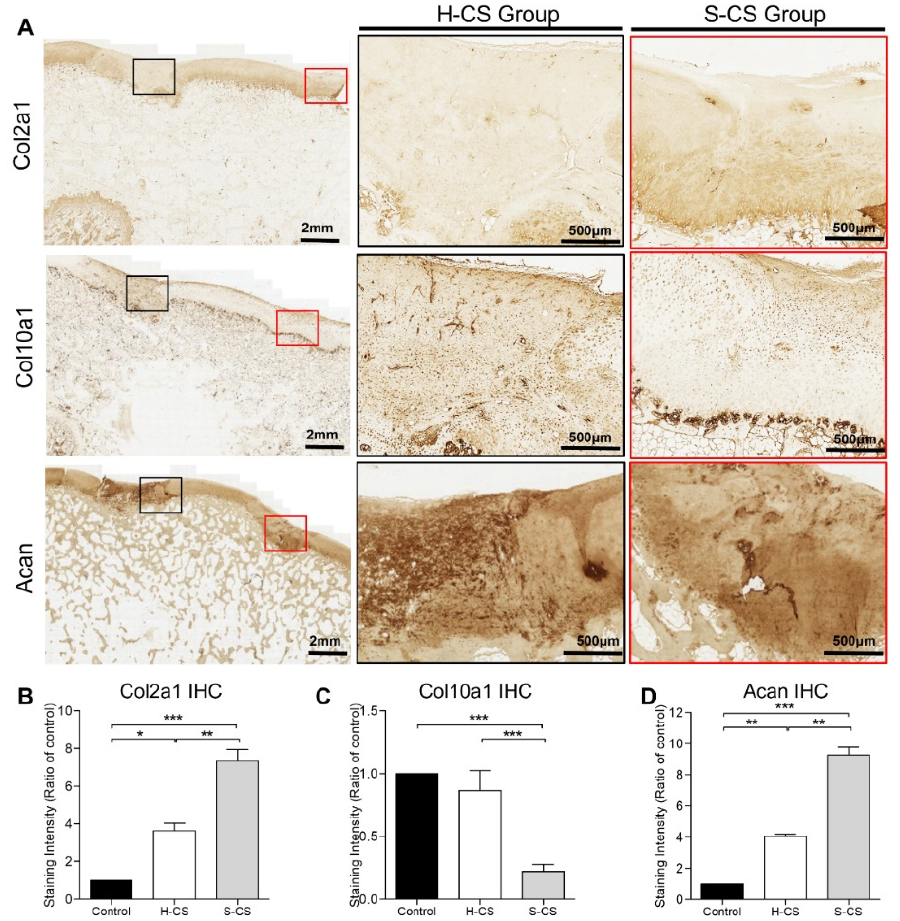
Figure 7. Immunohistochemical staining of regenerated cartilages. ( A ) The representative images of immunohistochemical staining for Col2a1, Col10a1, and Acan. The black and red boxes indicate the defect implanted with the heterogeneous chondrocyte sheets (H-CS) and the stratified chondrocyte sheets (S-CS), respectively. The low-powered view is as indicated in left panel (2 mm), and the high-powered views inside each box are present at right side (500 µm). The quantitative analysis of the integrated optical density (IOD) for ( B ) Col2a1 staining, ( C ) Col10a1 staining, and ( D ) Acan staining of the three groups at 12 weeks after surgery. (*, p < 0.05, **, p < 0.01, ***, p < 0.001).